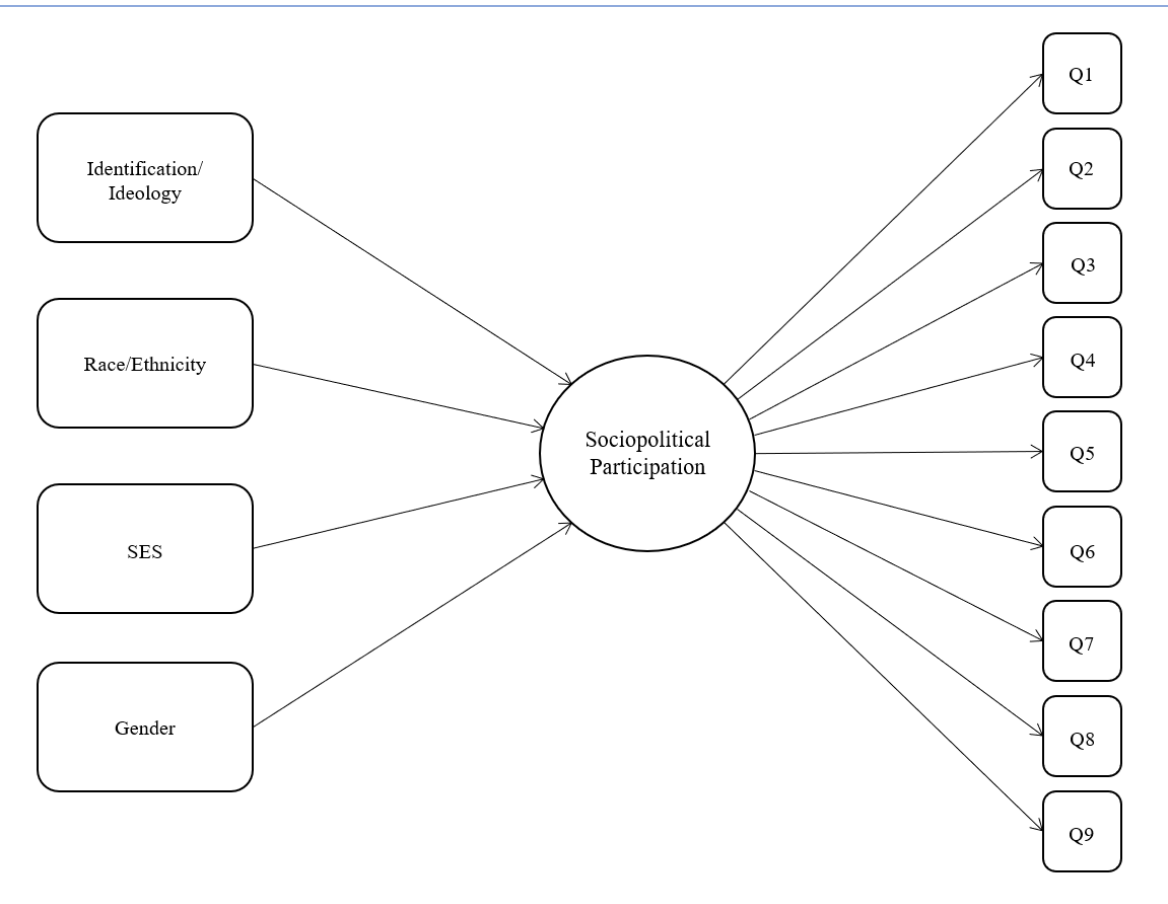
Figure 1. Conceptual MIMIC